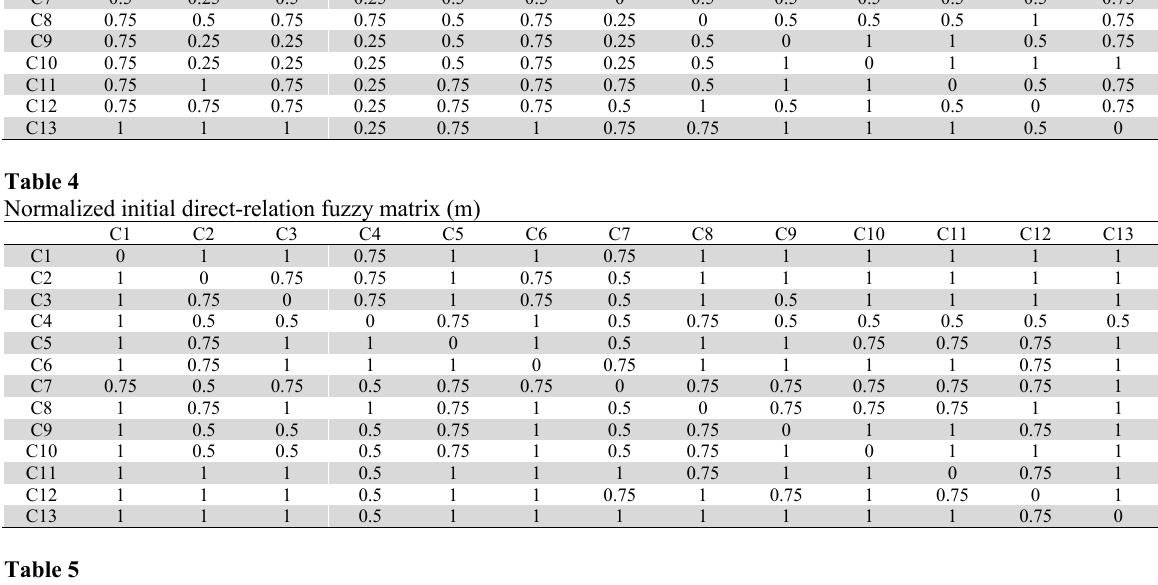
Total-relation fuzzy matrix